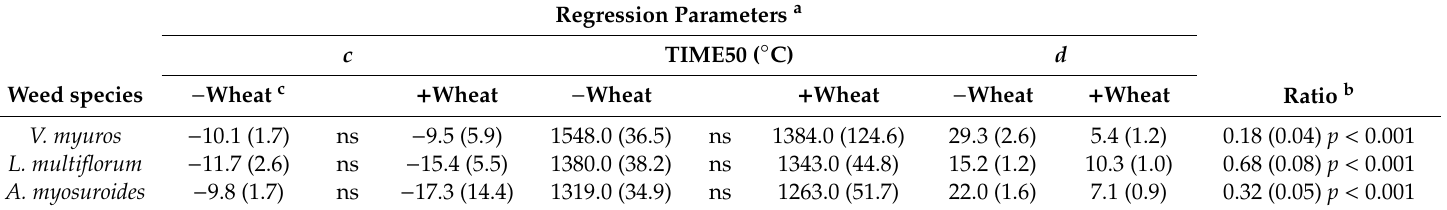
Table 3. Regression parameter estimates from log-logistic function fitted to per plant biomass accumulation of grass weeds in the absence and presence of winter wheat in 2018 / 19. Regression estimates were compared within grasses when they were grown in the absence and presence of crop at the 5% level of significance. Standard errors are given in the